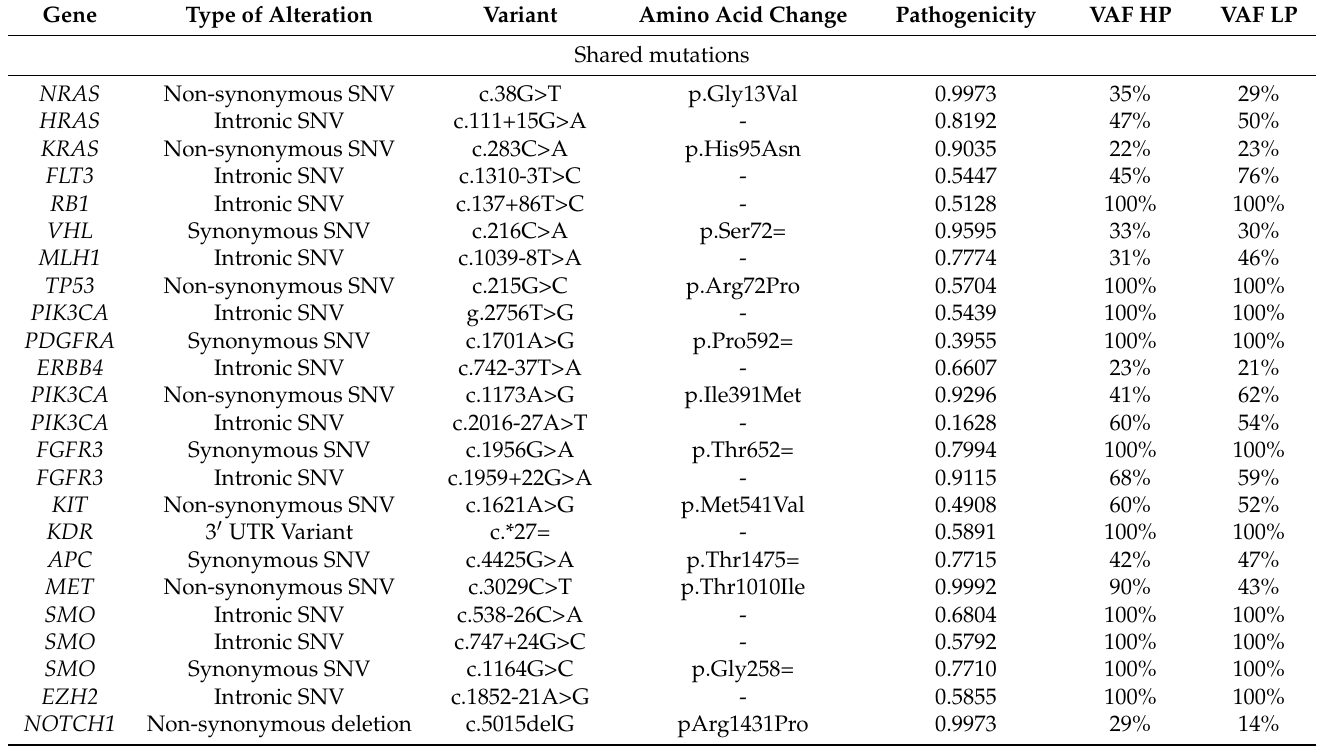
Table 5. Molecular characteristics of variants detected in tumor tissue of Patient